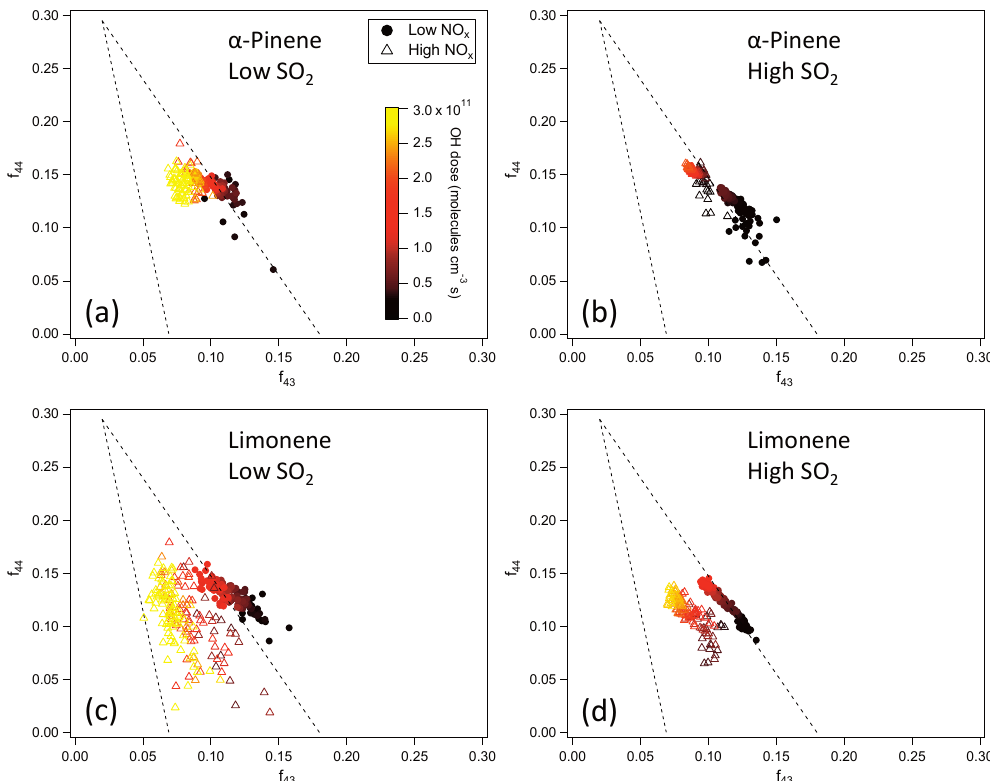
Figure 6. f 44 and f 43 of SOA from the photooxidation of α -pinene and limonene in different NO x and SO 2 conditions. (a) α -Pinene, low SO 2 ; (b) α -pinene, high SO 2 ; (c) limonene, low SO 2 ; (d) limonene, high SO 2 . Note that in the low-SO 2 , high-NO x condition (c) , the AMS signal of SOA from limonene oxidation was too low to derive reliable information due to the low particle mass concentration and small particle size. Therefore, the data for high NO x in (c) show an experiment with moderate SO 2 (2ppb) and high NO x instead.